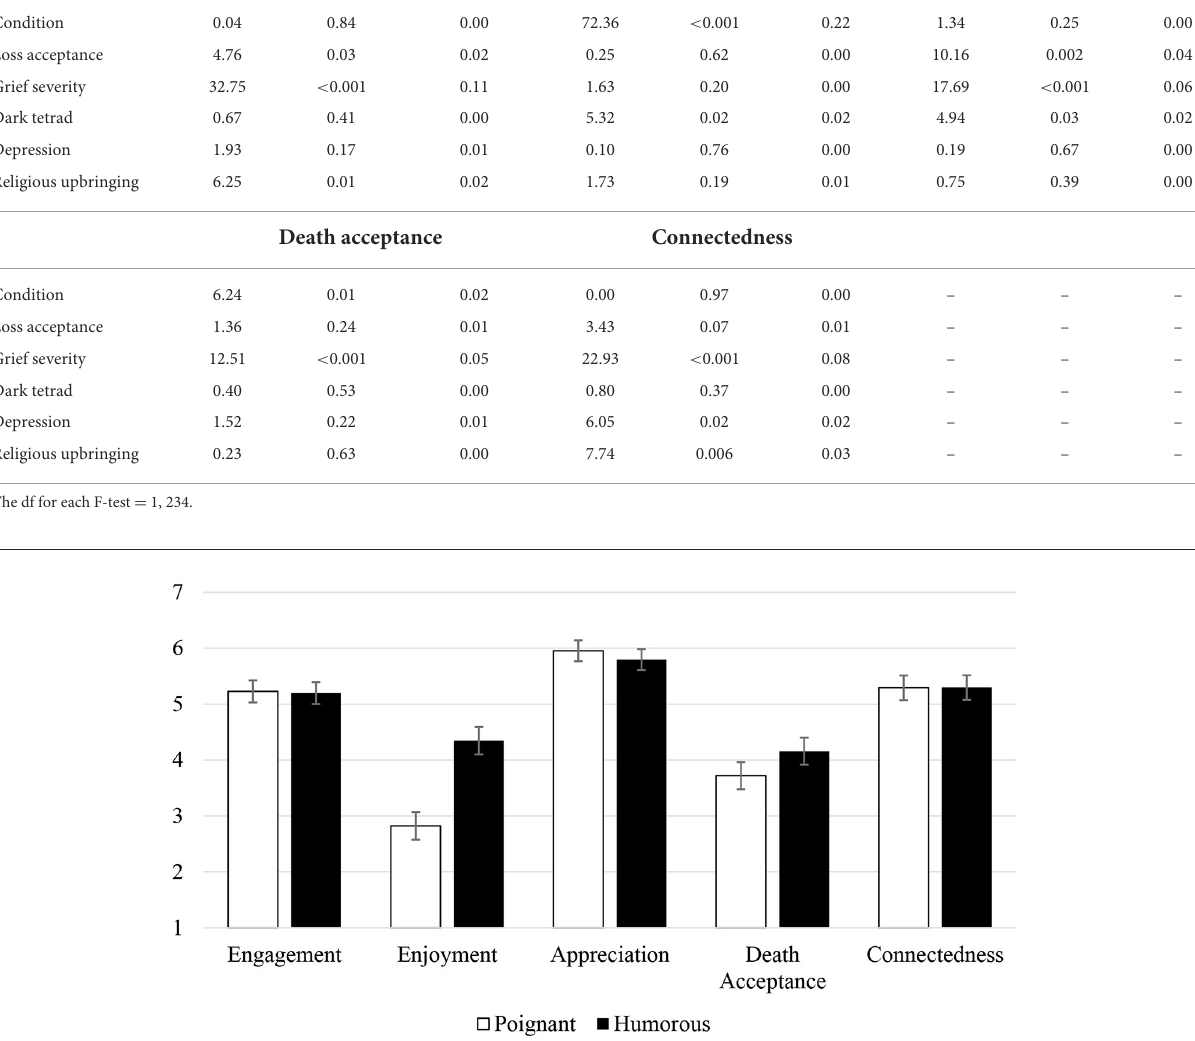
We also asked whether any of the specified covariates would significantly impact our narrative and outcome variables (RQ3). Our multivariate effects indicated a significant effect of each covariate across the dependent variables featured in our model: loss acceptance [Wilks’ Lambda = 0.95, F (5,230) = 2.46, p